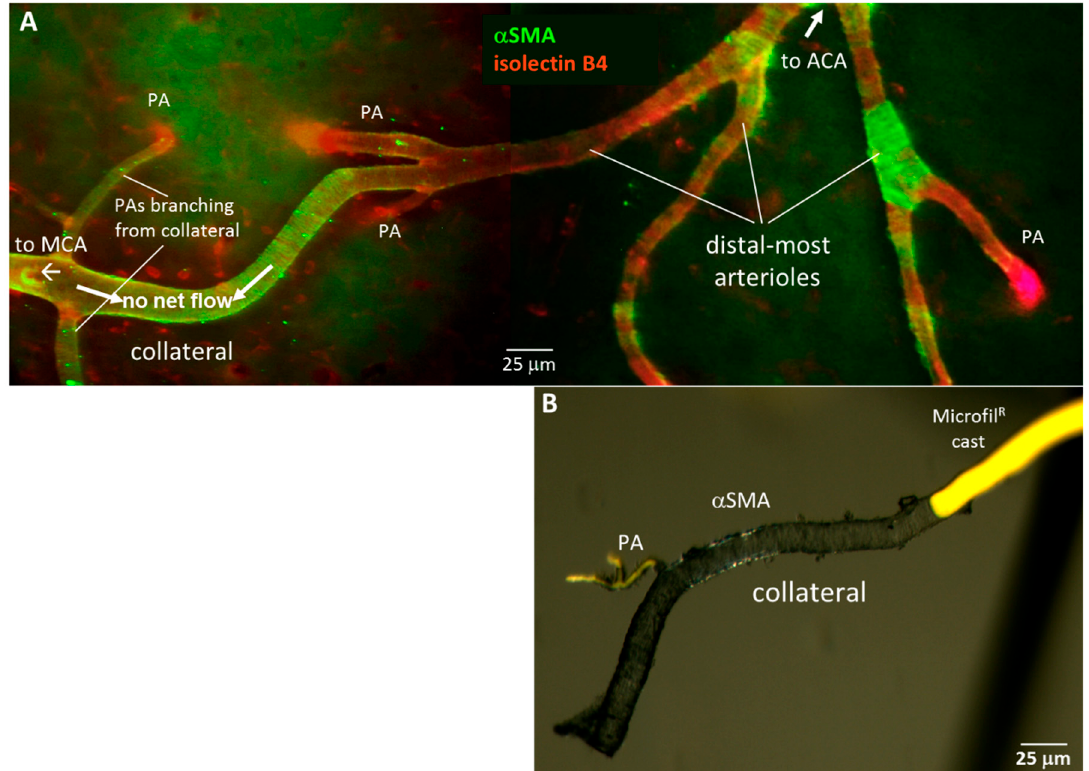
Figure 5. Collaterals are invested with a continuous layer of smooth muscle cells (SMCs), unlike distal-most arterioles (DMAs) that lack or have discontinuous SMCs. ( A ), Immuno-fluorescent staining of SMCs ( α SM-actin) and ECs (IB4-lectin). Representative image of pial collaterals, DMAs and penetrating arterioles (PA). ( B ), Brightfield image of α SMA-stained collateral and PA filled with yellow Microfil ® , then freed from surrounding pial membrane.